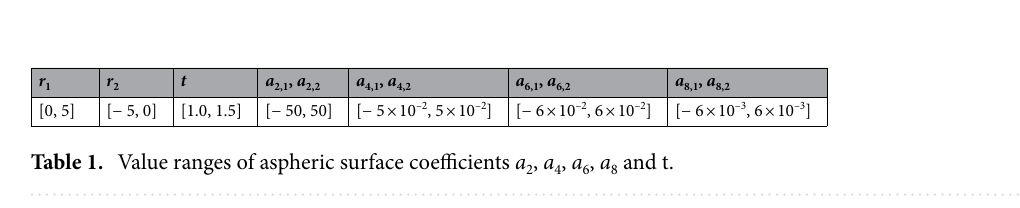
Figure 4. Intersection coordinates and included angle of the k th ray incident on the light receiving end face.